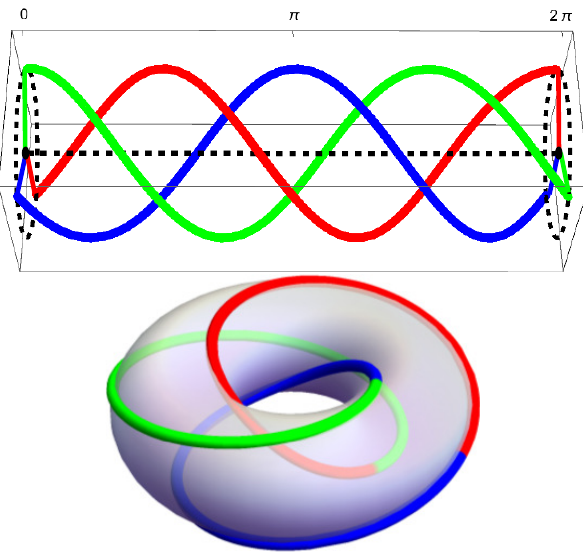
Figure 1. We show the (trefoil) torus knot with ( a; b ) = (1 ; 1) along the f -tube. The braid cyclically permutes the three points (green cycles. Hence they have to be identi(cid:12)ed, since the torus knot is actually closed, i.e. the circles at 0 and 2 (cid:25) on the left hand side are identi(cid:12)ed, cf. the right hand side. This identi(cid:12)cation gives rise to a monodromy